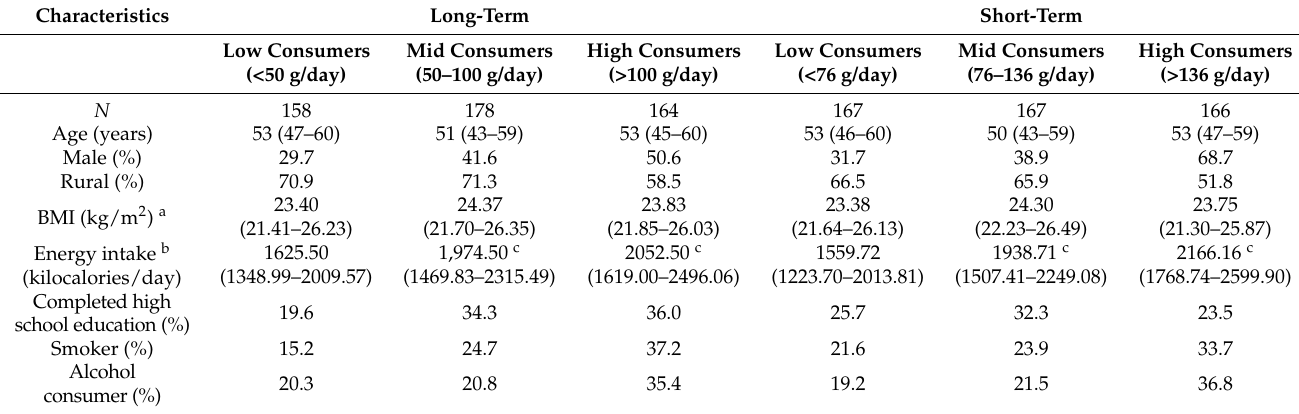
Table 1. Characteristics of the China Health and Nutrition Survey subjects, median (inter-quartile range) or percentage.